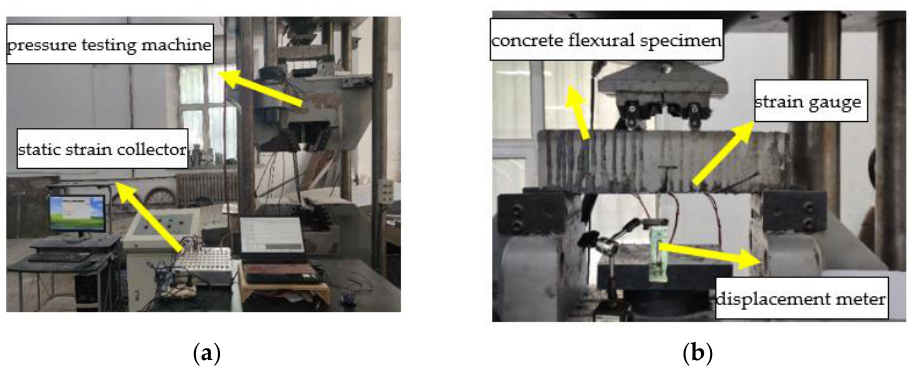
Figure 11. Bending mechanical test: ( a ) load general setting and ( b ) detail data collection setting.